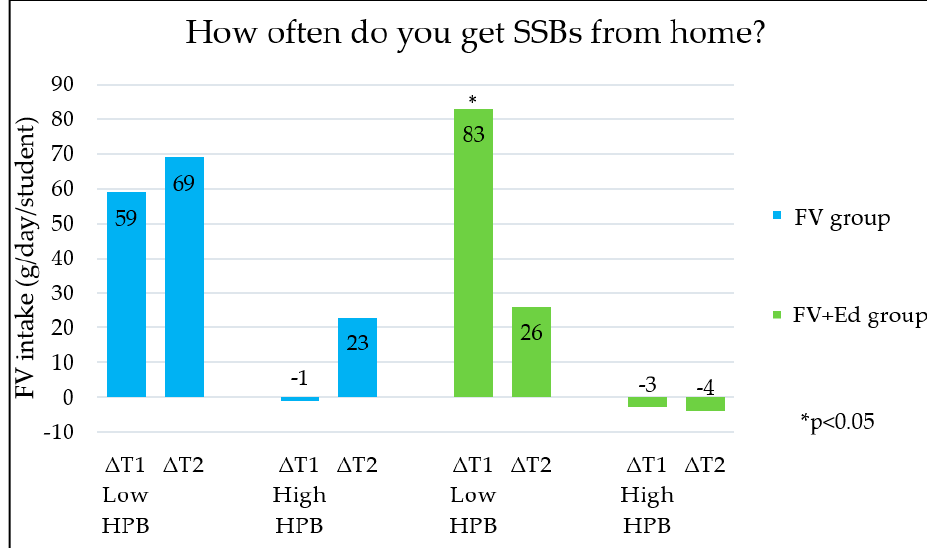
Figure 2. Differences in children’s FV intake, stratified by caregivers’ HPB in FV- and FV + Ed group, compared to the control group—SSBs provision. HPB = caregivers’ health promotion behaviour, ∆ T1 = Difference between T0 and T1, ∆ T2 = Difference between T0 and T2.